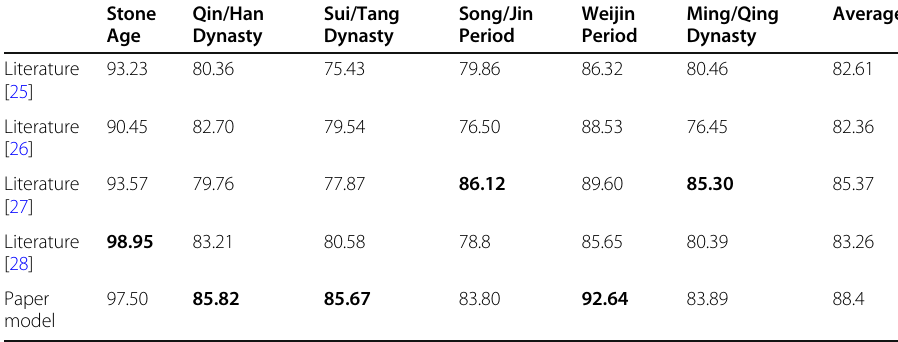
Table 5 Comparison of the accuracy rates of different models for different categories of murals Stone Age